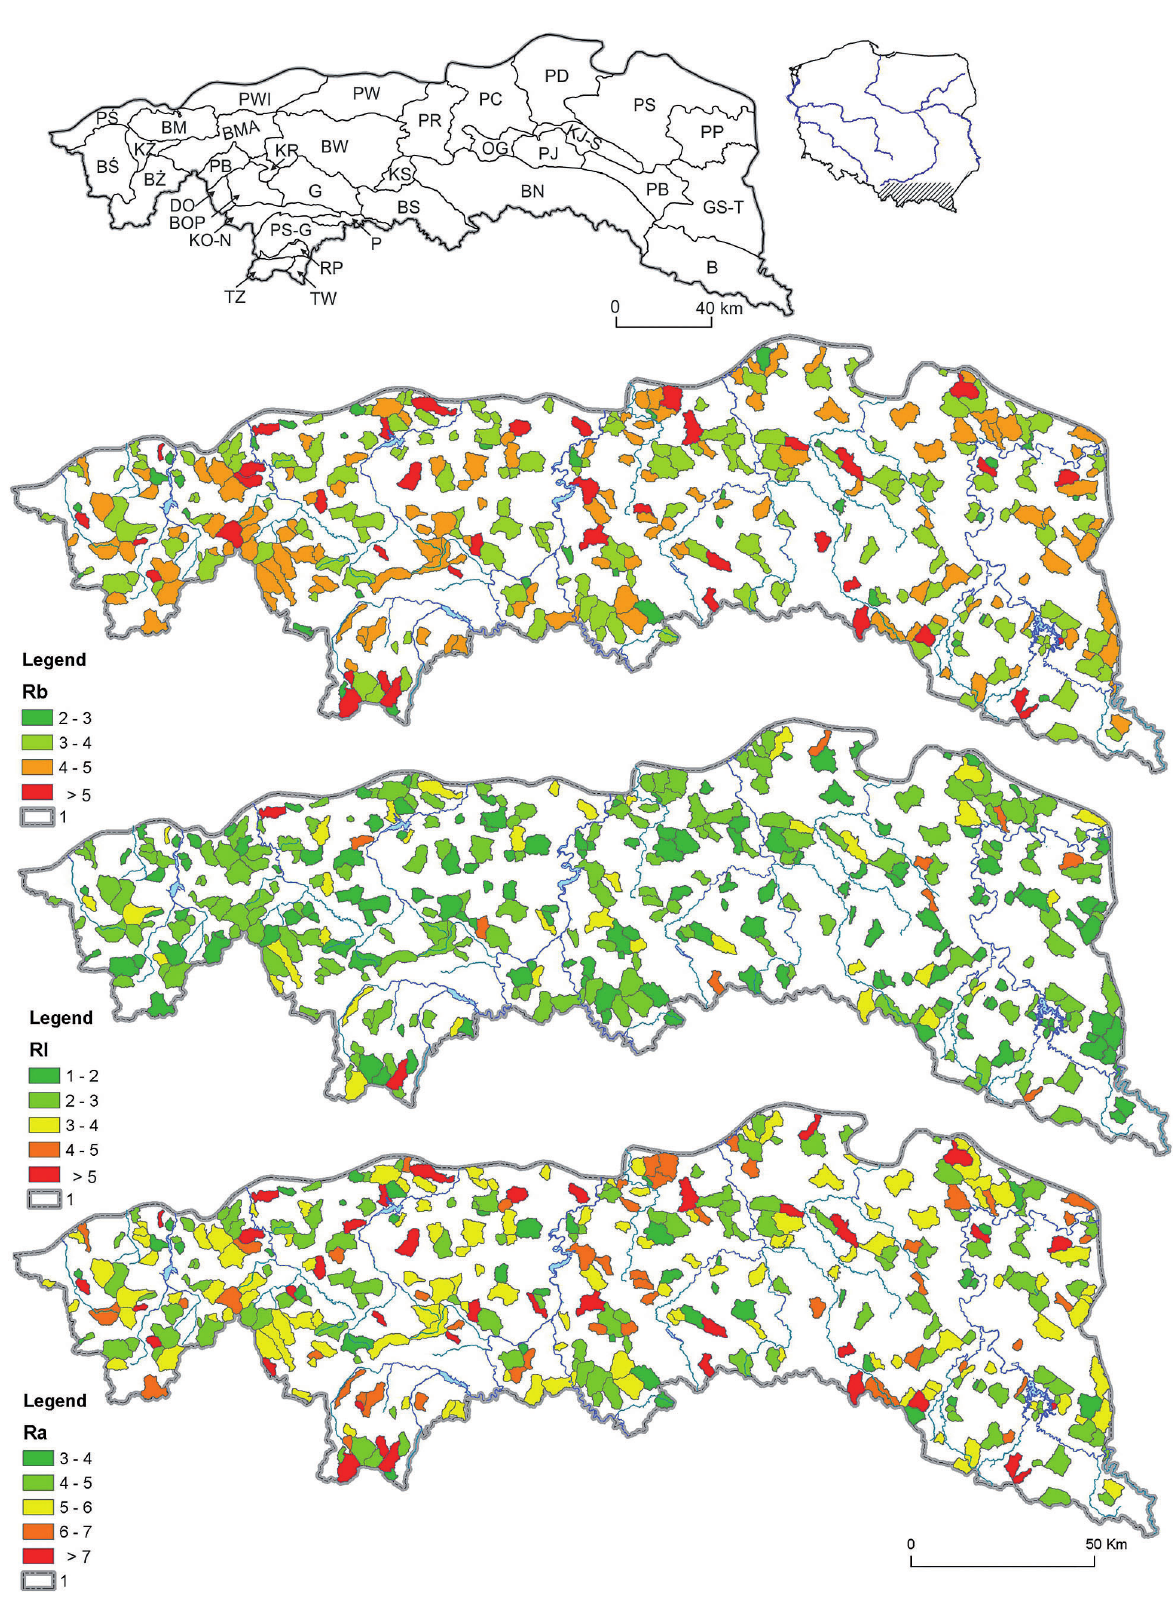
fig. 7. The bifurcation ratio (R